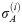
TS-Deep-LtM algorithm design framework.As it is shown the framework is composed of a model tuning module and a model selection module. A(i) denotes the set of scores for different parameter combinations of algorithm i. B represents the set of different σA(i). The finally “Best model” refers to the selected algorithm and the optimal feature combination of the training data.